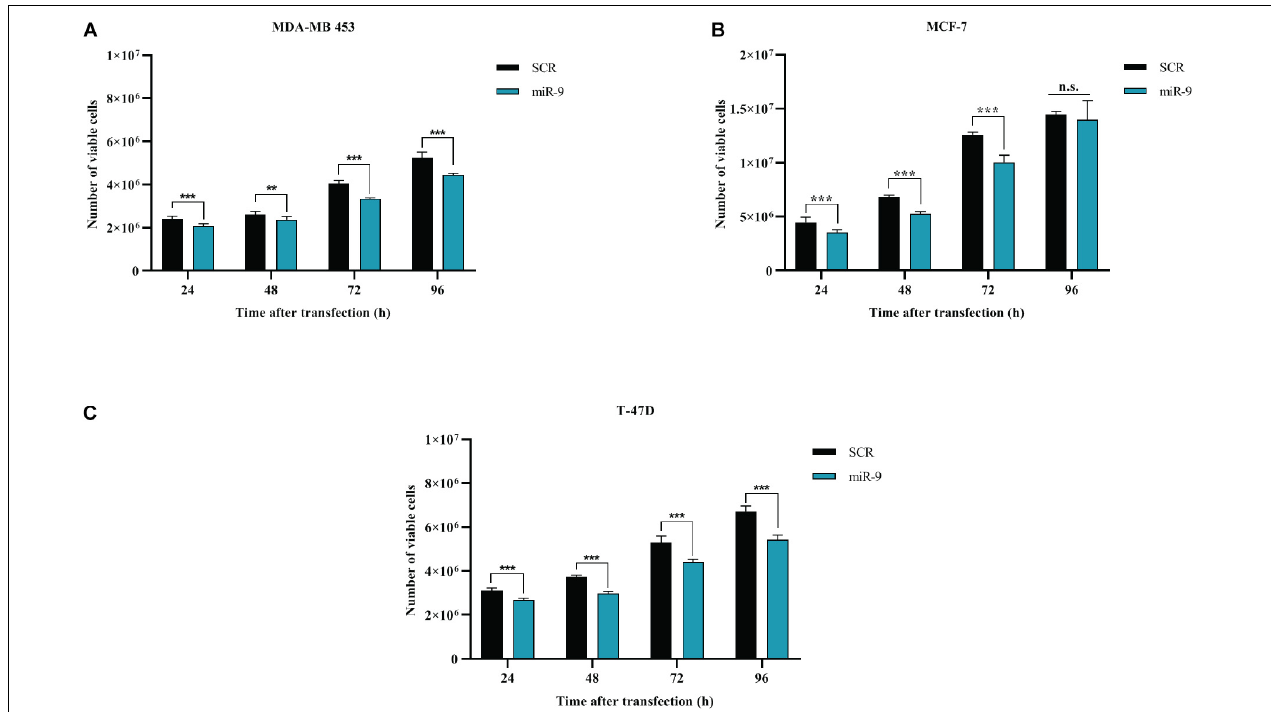
FIGURE 2 | Effects of miR-9-5p (mir-9) on proliferation of BC cell lines (A) MDA-MB-453 (B) MCF-7 ( C ) T-47D. ** p < 0.01, *** p < 0.001, n.s., not significant. Multiple t -test, corrected for multiple comparison using the Holm-Sidak method in (A–C) .